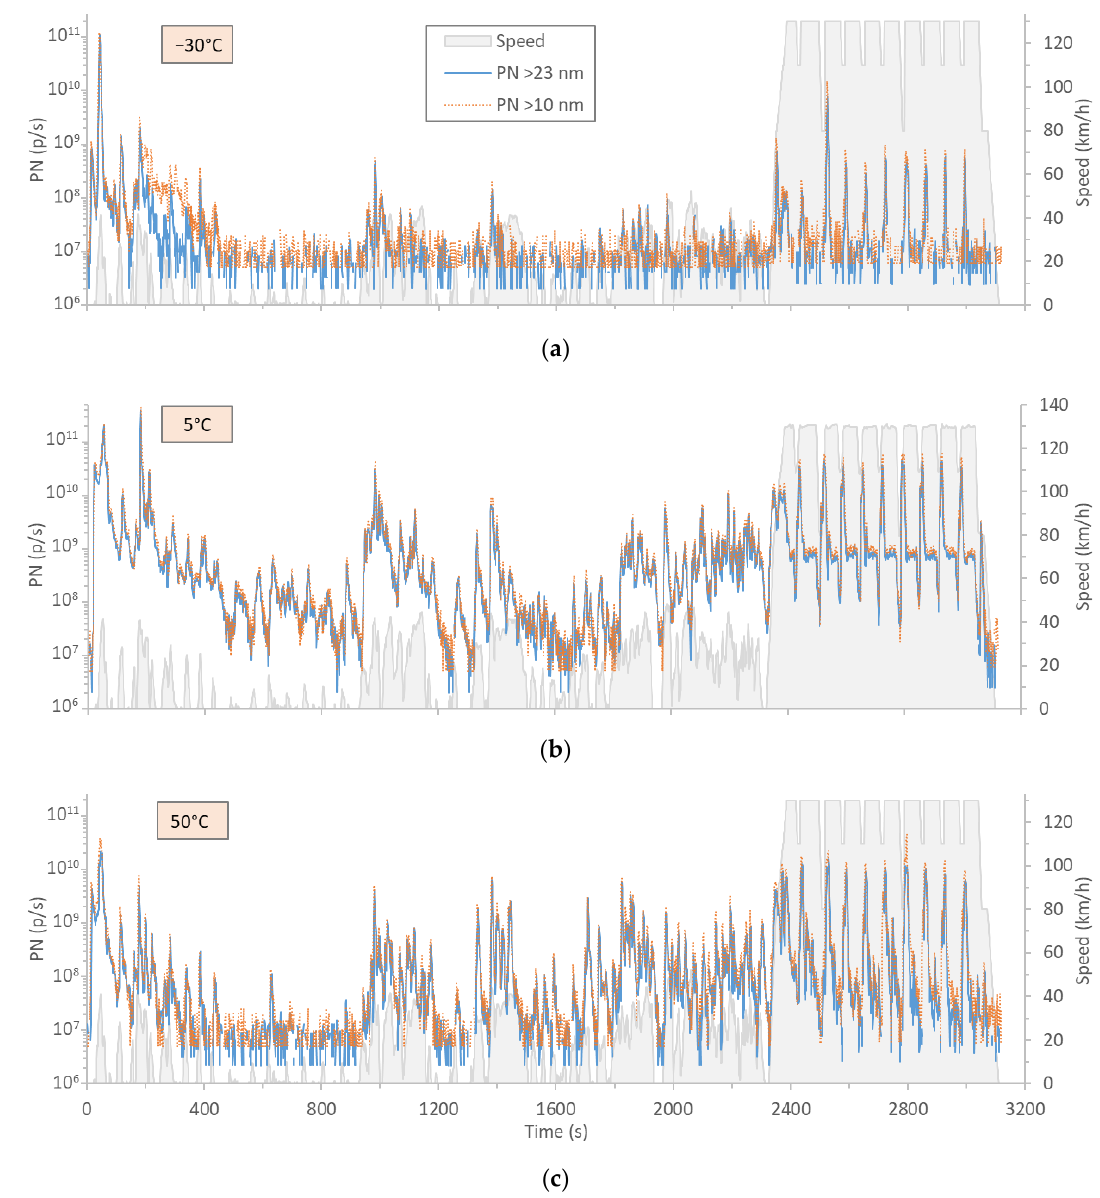
Figure 3. Urban cycle TfL and motorway BAB driven on the chassis dynamometer: ( a ) Particle number (PN) > 23 (blue line) and >10 nm (orange line) at −30 °C; ( b ) 5 °C, and; ( c ) 50 °C. The speed profile is given in grey background.